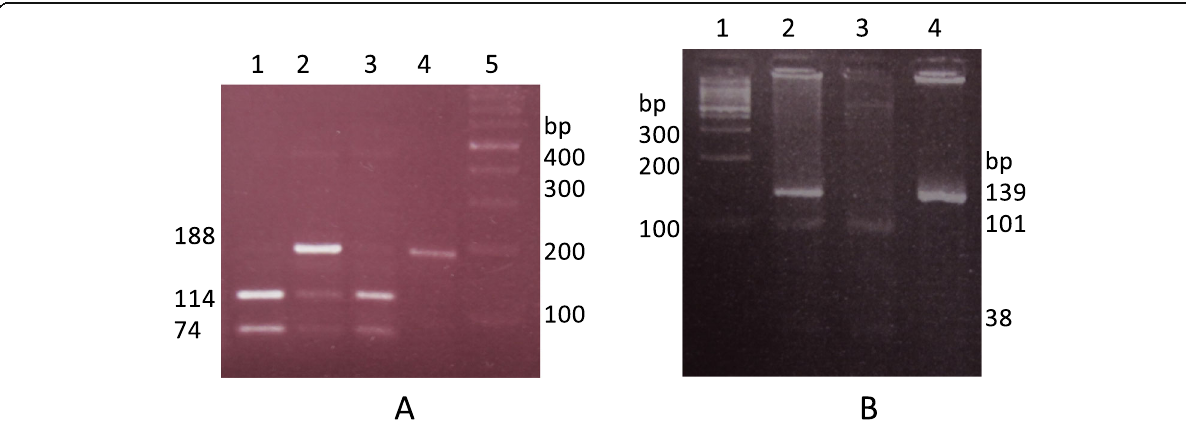
Fig. 1 3% agarose gel electrophoresis of the restriction enzyme digestion ( a ) 188 bp PCR fragment of the MUC1 gene restriction enzyme digestion results using AIWNI enzyme; lane 1 and 3 shows homozygous AA, lane 2 heterozygous GA genotype and lane 4 shows homozygous GG genotype respectively, lane 5 shows 100 bp DNA marker ( b ) Restriction enzyme map of the 139 bp PCR fragment of the PSCA gene using NIaIII enzyme. Lane 1 = 100 bp DNA marker, lane 2 heterozygous CT, lane 3 (101 and 39 bp) shows homozygous TT and lane 4, uncut PCR product shows homozygous CC genotype